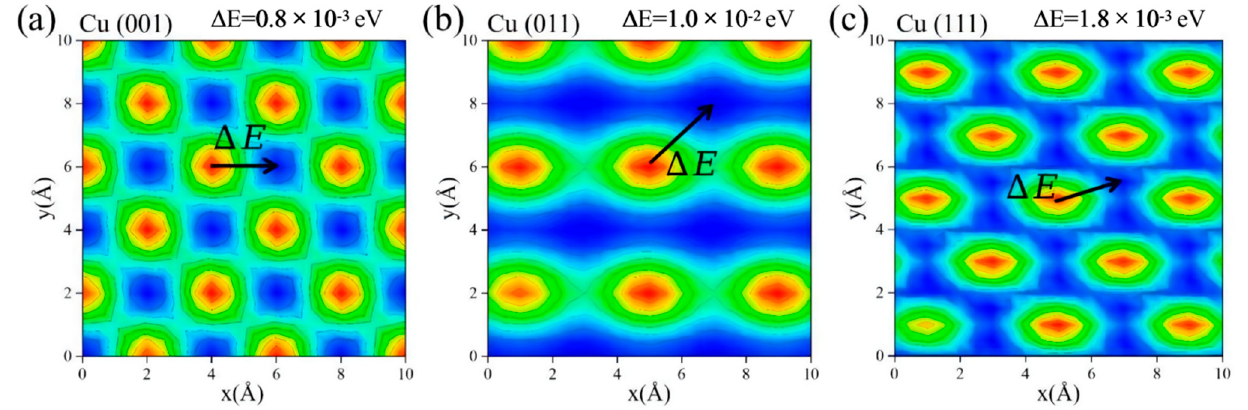
Figure 5. ( a – c ) Potential energy distribution contour of adjacent graphene layers with different atomic structures. ∆E represents the difference value between the maximum and minimum potential energy.